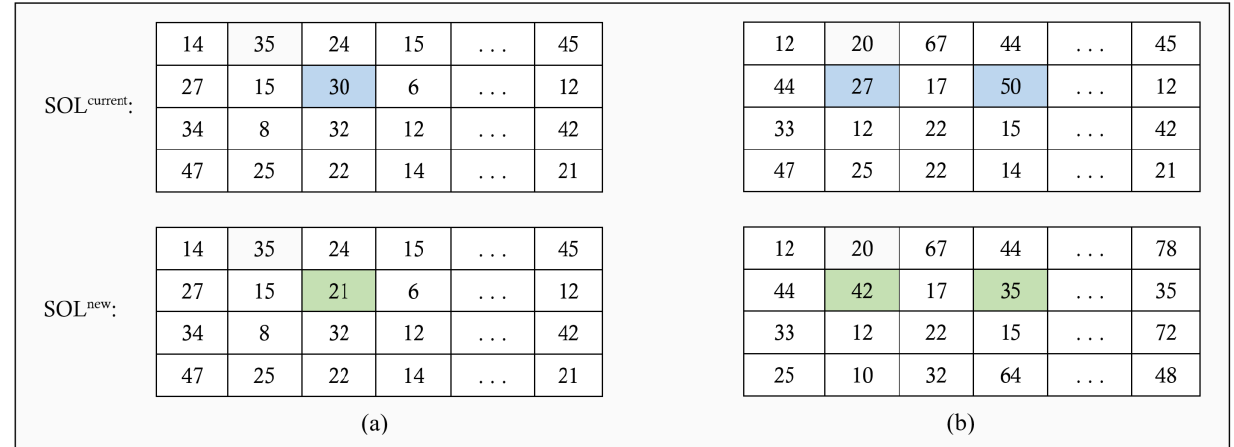
Figure 4. Integer local search operators: ( a ) I-Swap, and ( b ) I-Exchange. The variables selected for change in SOL current and the changed variables in SOL new are shown in blue and green, respectively.